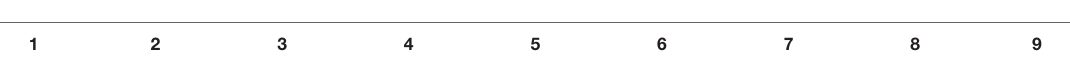
TaBle 1 | Correlations.